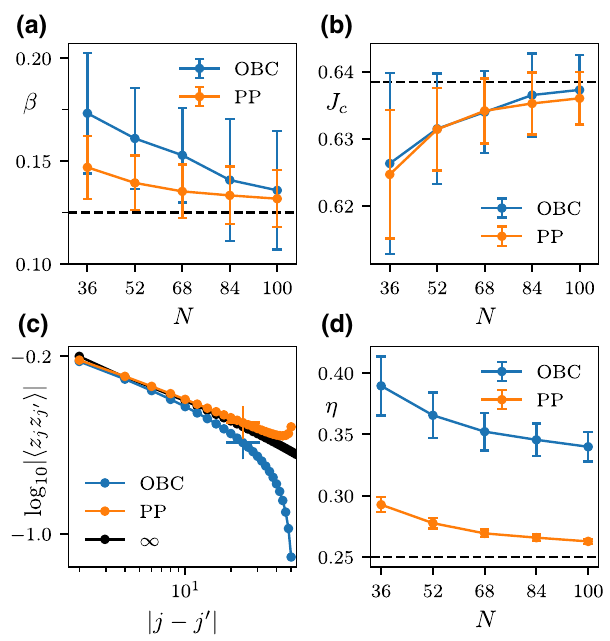
FIG. 9. (a), (b) Convergence of the values ( J c , β) obtained from the FSS analysis with growing sizes N of the OBC GSs and the PP states. The bars give the standard error. The dashed line indicates the target values. (c) The correlators OBC GS and the PP state of size N = 100, and in the infinite ground state, all at the average J c obtained from FSS with the PP state of size N = 100. The crosses mark the end of the range (at j = N / 4), which is fitted with the polynomial decay, Eq. (21). (d) Convergence of the retrieved critical exponent η to the target value (dashed line) with growing sizes N of the OBC GSs and the PP